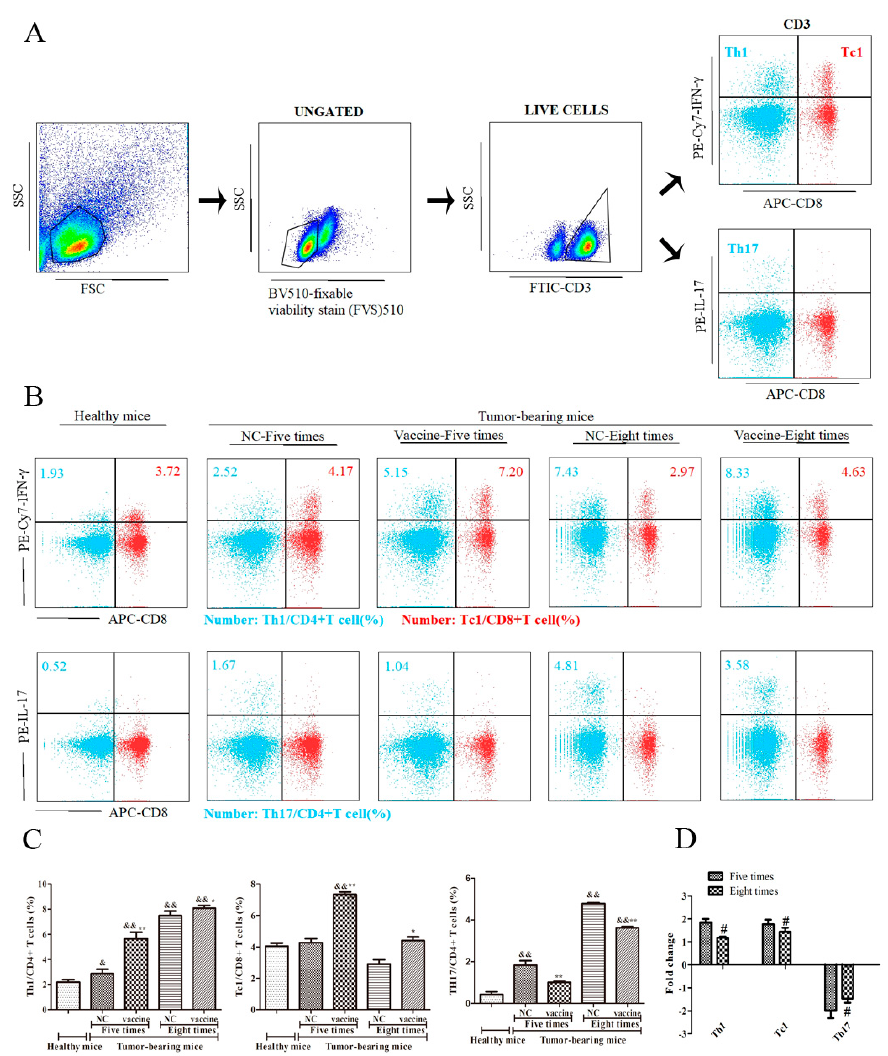
Figure 4. The effect of immunization cycles on recombinant MUC1-MBP vaccine-induced Th1, Tc1, and Th17 cells in the spleen in the preventive mouse model. ( A – D ) Mice were euthanized 15 days after tumor inoculation and splenic mononuclear cells from each group were stimulated in vitro with a cocktail (2 µL/mL) for 5 h. Then, the cells were incubated with BV510-conjugated anti-fixable viability stain 510, FITC-conjugated anti-CD3, antigen-presenting cells (APC)-conjugated anti-CD8, PE/CY7-conjugated anti-IFN- γ , and PE-conjugated anti-IL-17 Abs. ( A ) Dot plots showing the gating strategy. ( B ) The percentages of Th1, Tc1, and Th17 cells in the spleen are shown in the dot plots of the flow cytometry data. ( C ) The percentages of Th1, Tc1, and Th17 cells in the spleen are shown in the data table. ( D ) Fold change (CF) represents the ratio of the experimental group to the NC group. Increased fold change = the experimental group/NC group and decreased fold change = − [NC group/the experimental group]. && p < 0.01 vs. healthy mice. * p < 0.05, ** p < 0.01 vs. the NC group. # p < 0.05 vs. the group immunized five times.